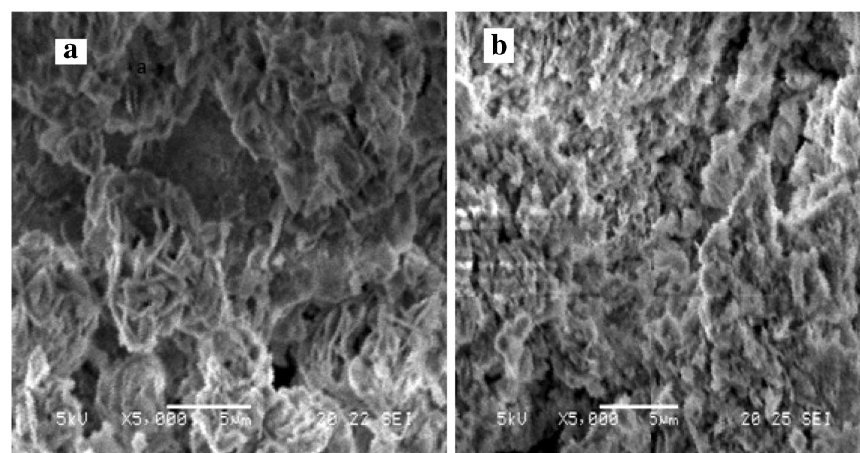
Fig. 12 SEM photographs of